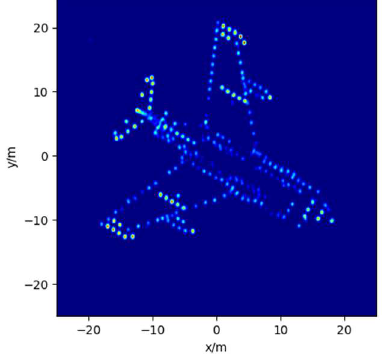
Figure 5. Imaging result of point target simulation data via MIMO-LI-Net.